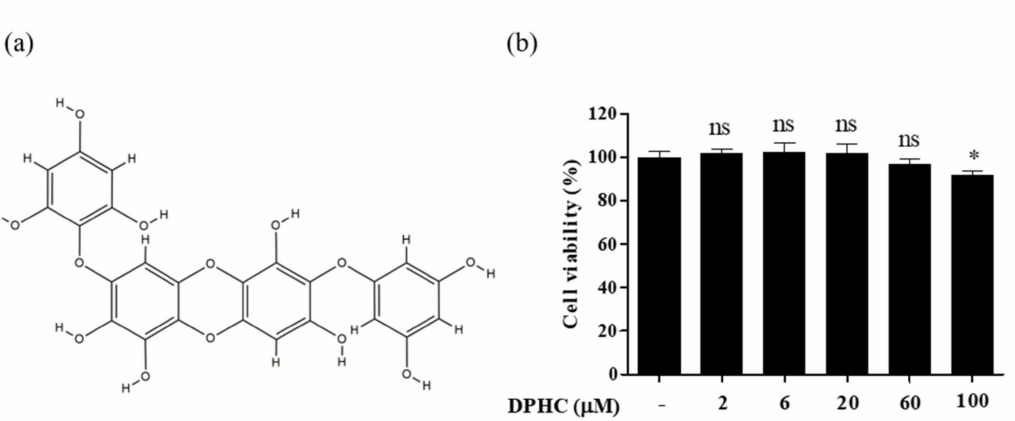
Figure 1. ( a ) Structure of diphlorethohydroxycarmalol (DPHC) ( b ) Cell viability analysis of EA.hy926 cells treated with different concentrations of DPHC. EA.hy926 cells were incubated with different concentrations of DPHC (0, 6, 20, 60, and 100 µ M) for 24 h, and cell viability was determined by 3-(4-5-dimethyl-2yl)-2-5-diphynyltetrasolium bromide (MTT) assay. Each column and bar represent the mean ± standard deviation (S.D.). * p < 0.05, significant difference compared to the control group. DPHC: diphlorethohydroxycarmalol; ns: not